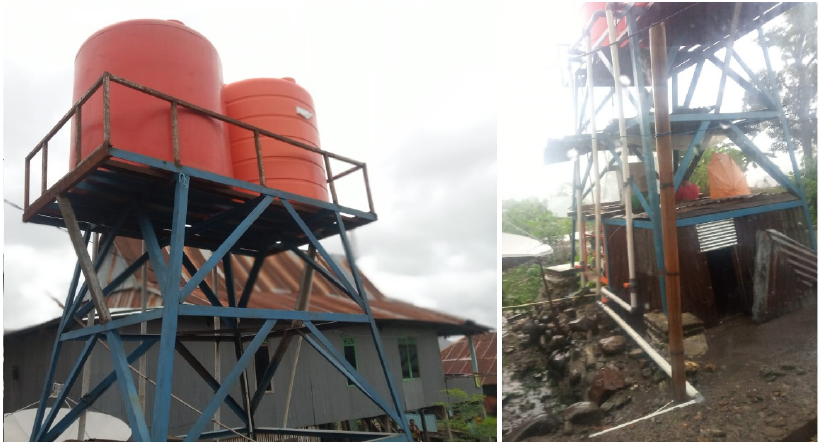
Figure 1. Manual valve regulation for agricultural irrigation in Jeneponto, South Sulawesi, Indonesia.